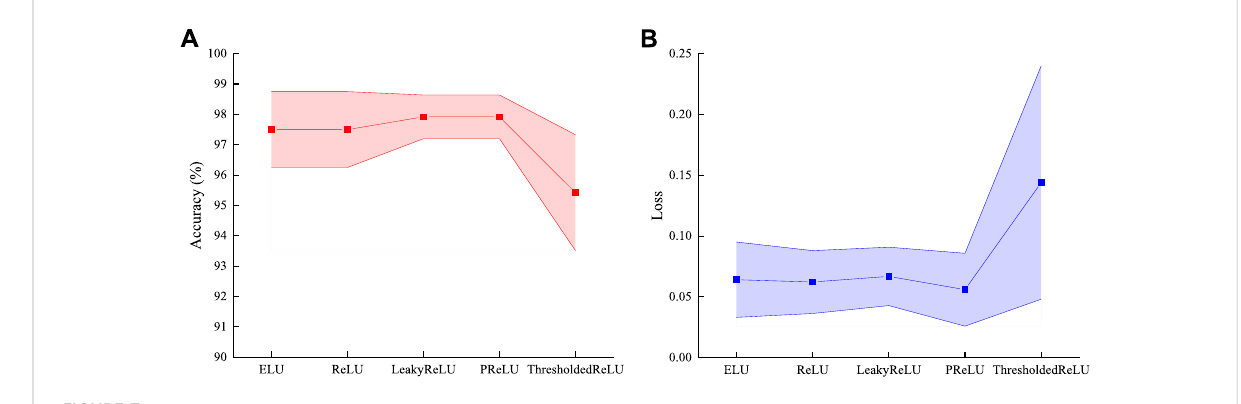
FIGURE 7 Results of the 1D-CNN-B network under different activation functions. (A) Accuracy and (B)